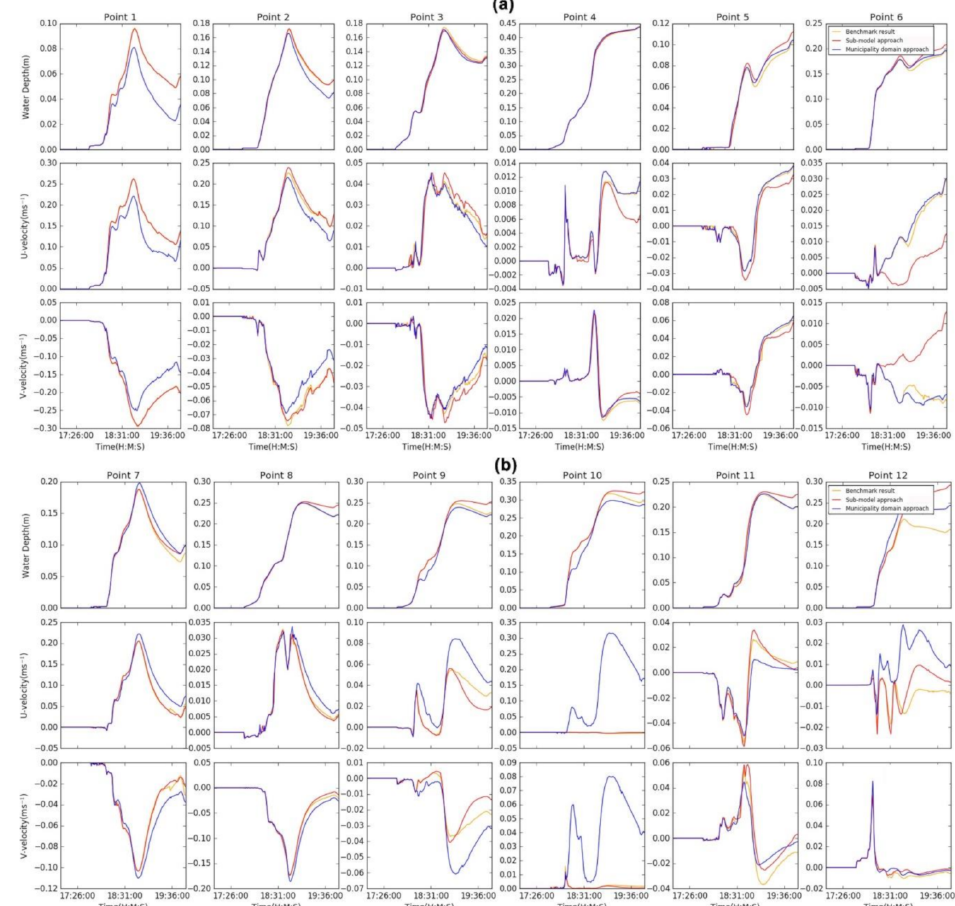
Figure 10. Flood depth, u- and v-velocity hydrographs for points 1–12. ( a ) The L-shaped flow pattern; ( b ) the F-shaped flow